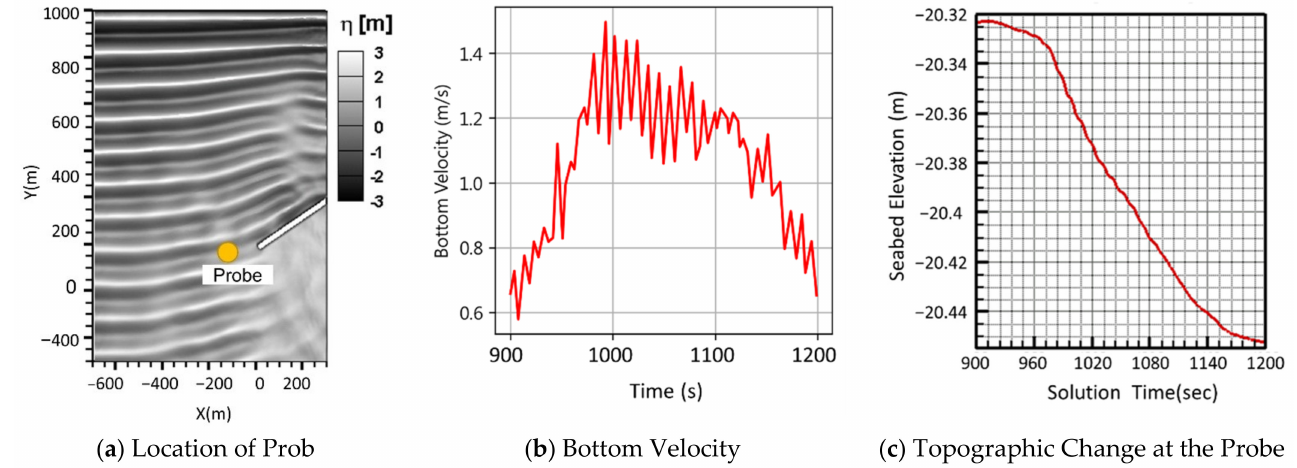
Figure 33. Bottom velocity and topographic change at the probe location.